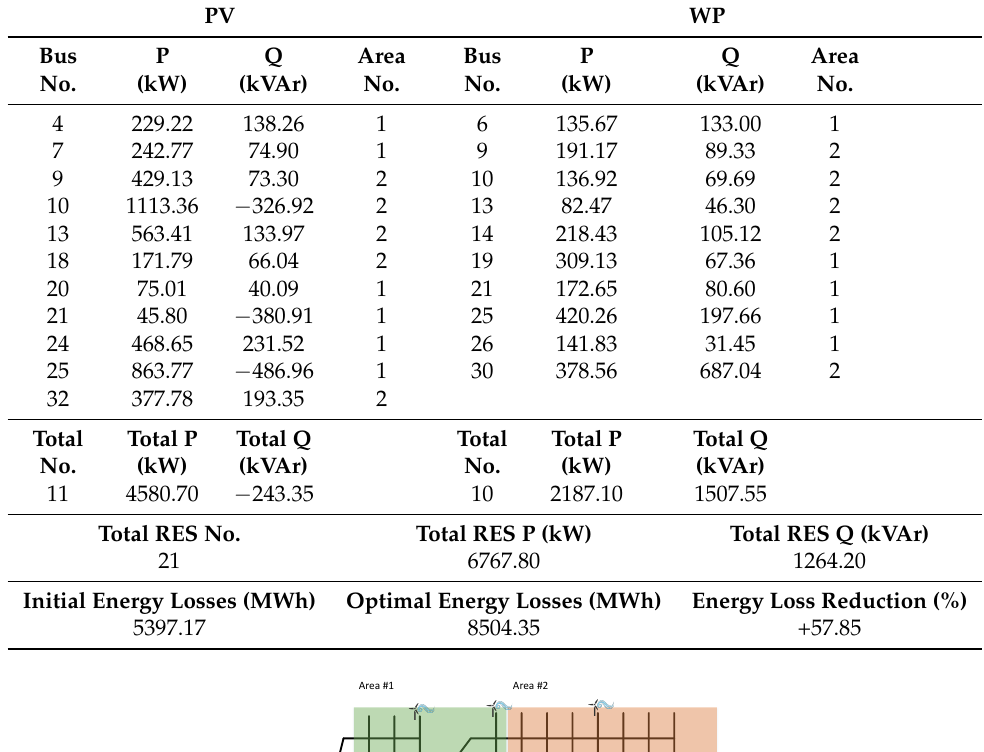
Table 14. Snapshot approach—Max Value—Scenario #3.